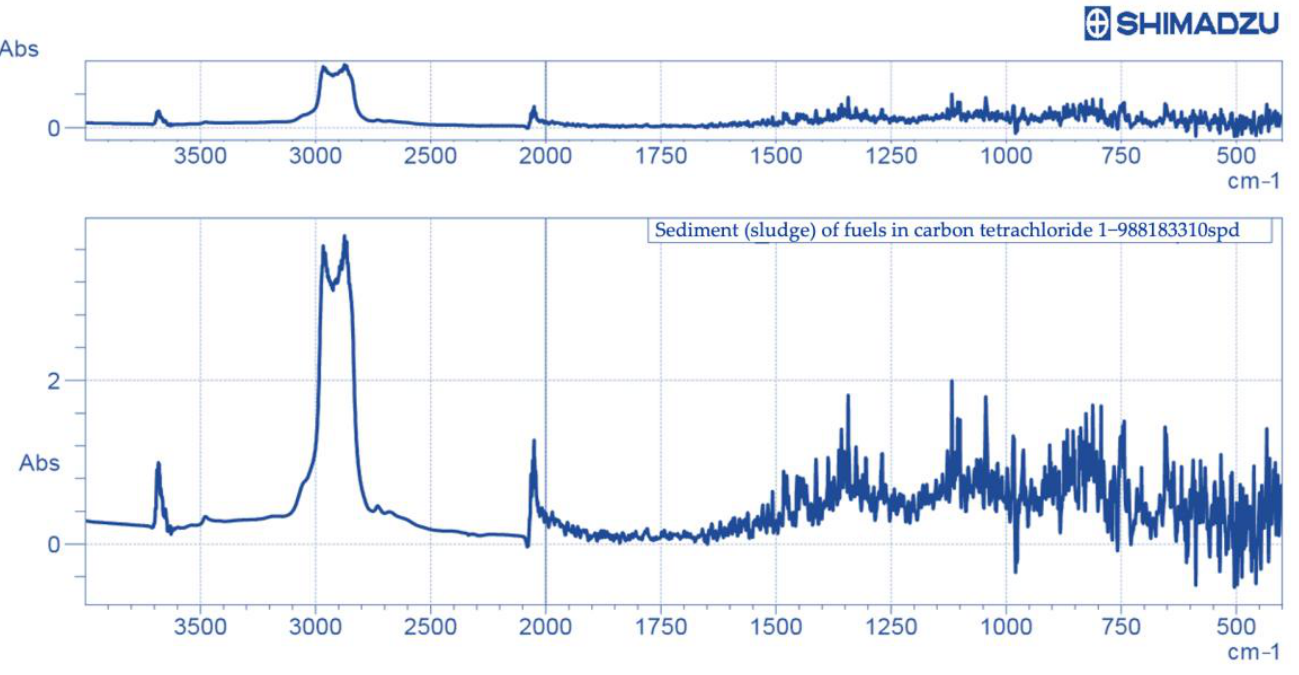
Figure 10. IR spectrum of sediment (sludge) of fuels in carbon tetrachloride. Wave numbers of about 3000 cm − 1 corresponded to n-paraffins, which confirmed the results obtained by the chromatographic